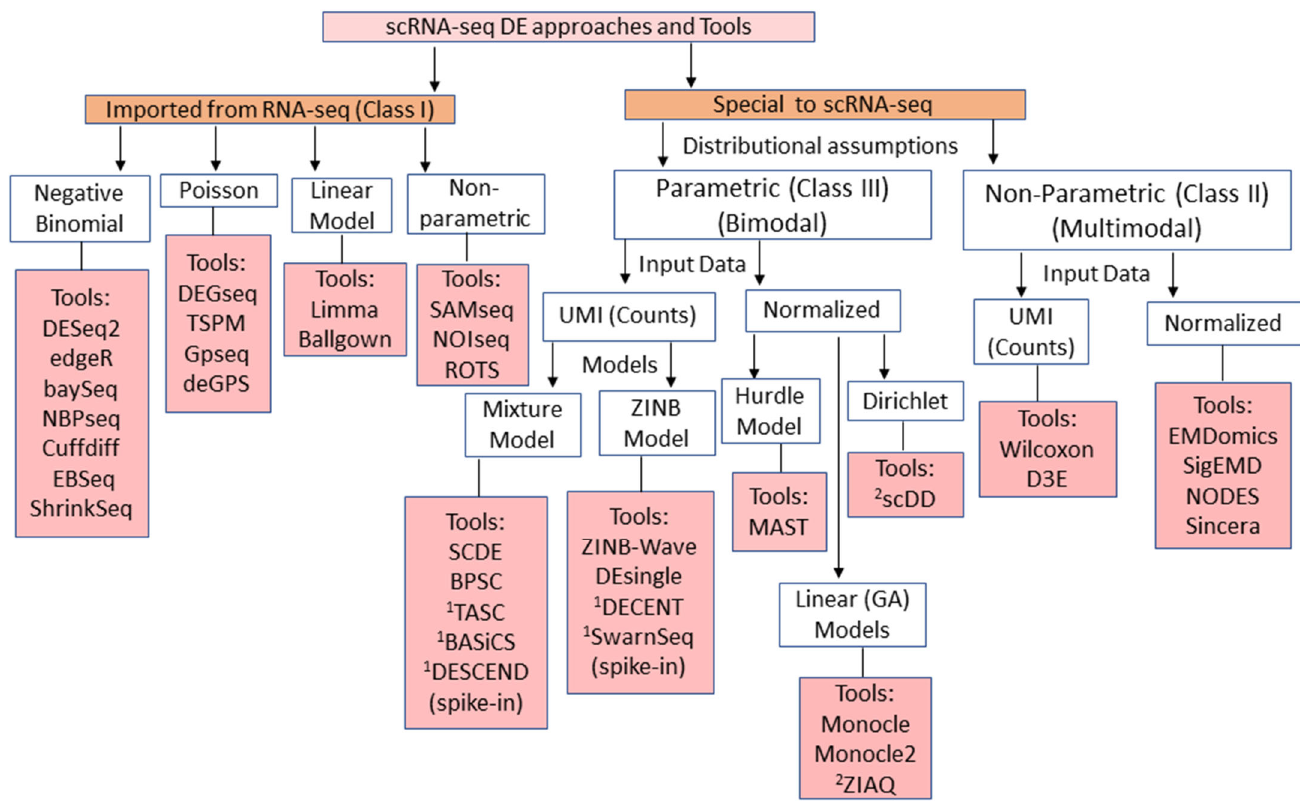
Figure 1. Schematic Representation of Classification of scRNA-seq DE Methods and Tools. Schematic overview illustrating the breakup of the methods that can be adapted from the RNA-seq practice to fit scRNA-seq data (Class I) as well as those specifically designed for single-cell (Classes II, III) based on the different distribution models that they fit. Different example tools belonging to each category are listed in pink color boxes. 1 Methods use the external RNA spike-ins and 2 Parametric approaches but can handle multi ‐ modality of the data. Table 1. Description of scRNA ‐ seq DE methods. SN.